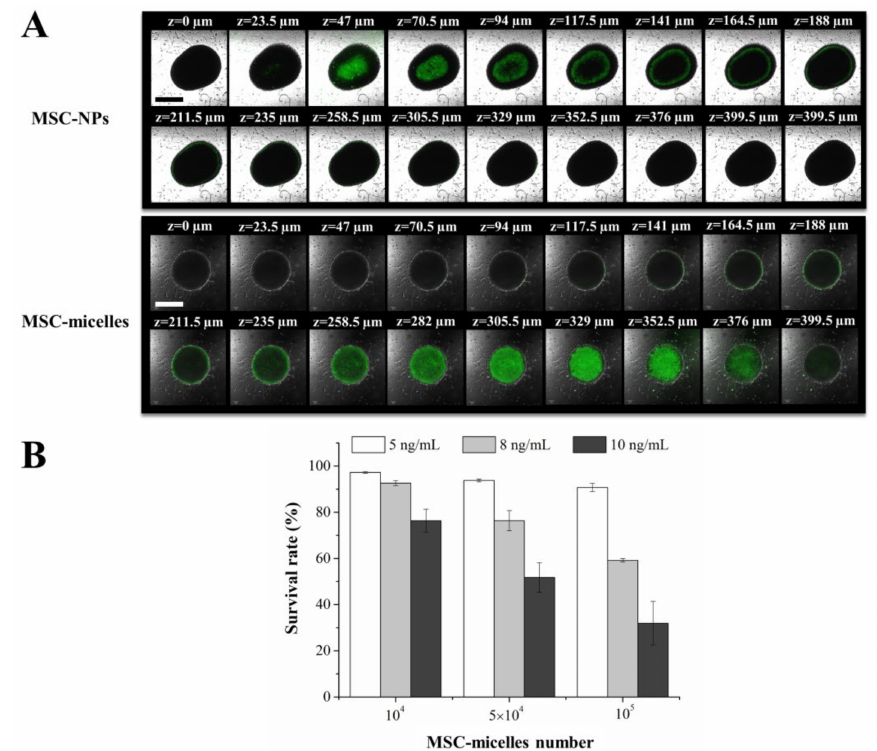
Figure 6. ( A ) Z-stack image of C6 spheroids after incubation with MSC-micelles and MSC-NPs loaded with coumarin 6 (bar = 500 µ m). ( B ) Viability of spheroids exposed to MSC-micelles and MSC-NPs loaded with PTX at different drug loading and MSC number.